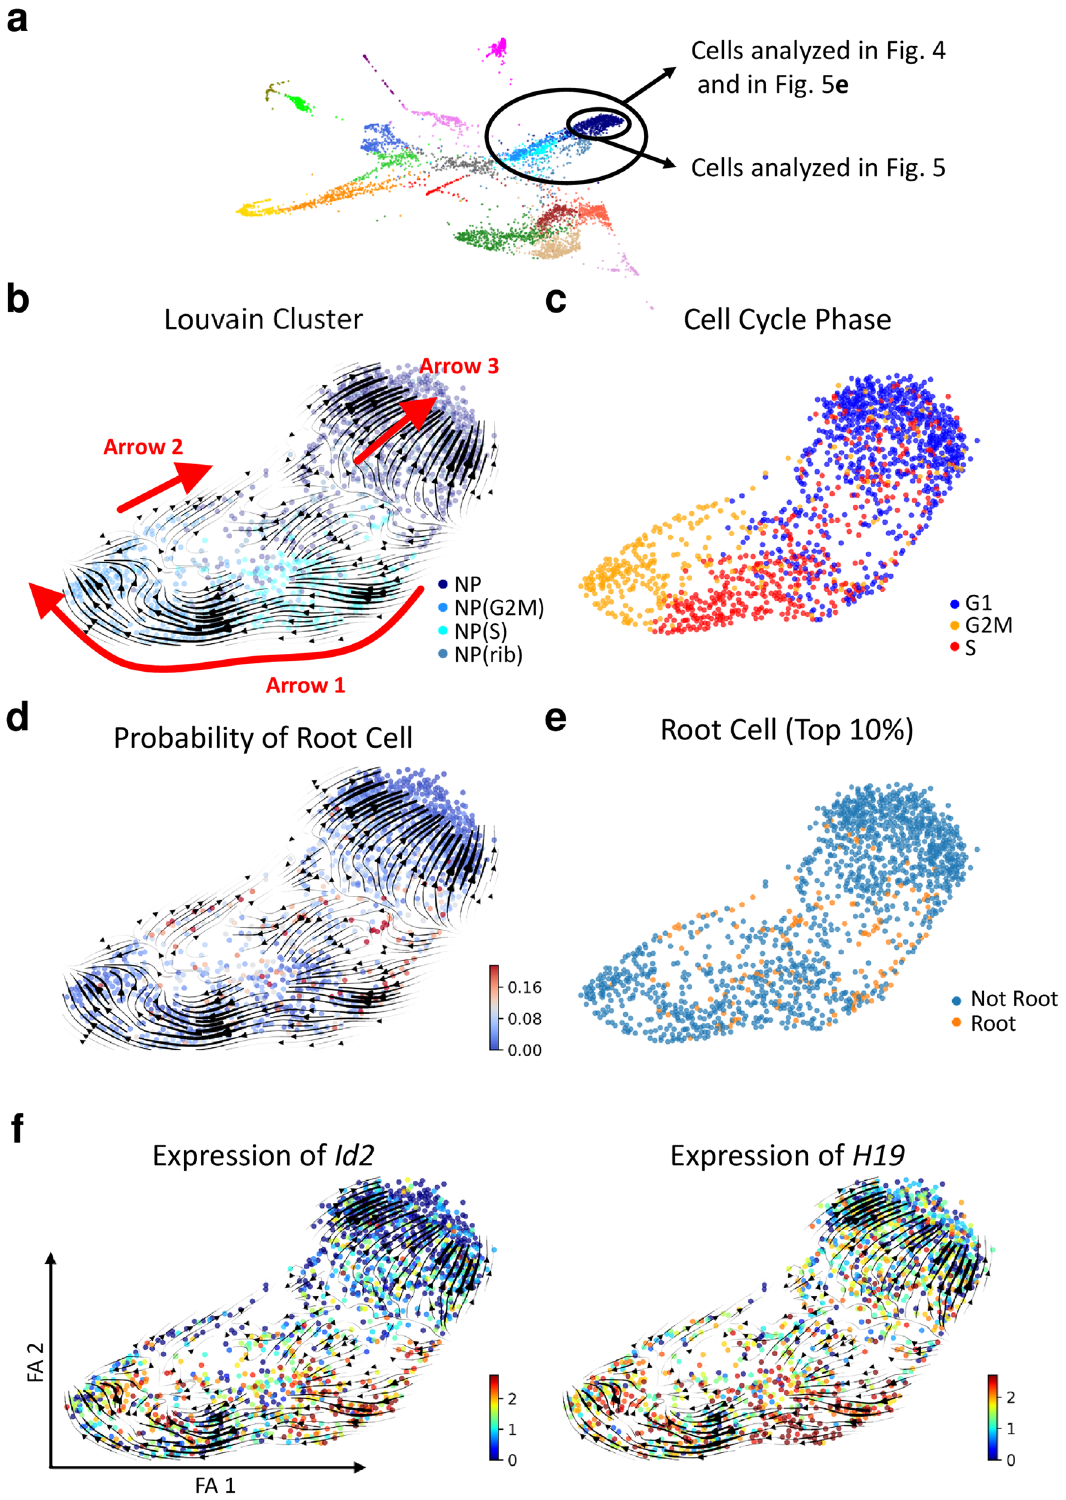
Figure 4. Identification of cells with high root probability in the nephron progenitors. ( a ) A subset consisting of the nephron progenitor (NP), S-phase NP (NP(S)), G2M-phase NP (NP(G2M)), and ribosome-enriched NP (NP(ribo)) clusters was analyzed. ( b ) The subset was mapped by PAGA-initialized ForceAtlas2. Stream-embedded RNA velocities were overlaid. Three major RNA velocity streams (arrows 1, 2, and 3) are observed. ( c ) The cell cycle phase is visualized. ( d ) The probability of RNA velocity root is calculated using CellRank. Red dots indicate cells with higher root probability. ( e ) Cells with top 10% root probability are visualized. ( f ) mRNA expression levels of Id2 and H19 are shown. Data were analyzed using Scanpy version 1.4.4.post1 (https ://scanp y.readt hedoc s.io/en/stabl e/), scVelo version 0.1.25 (https ://scvel o.readt hedoc s.io/), and CellRank version 1.1.dev264+g61bbda4 (https ://cellr ank.readt hedoc s.io/en/stabl